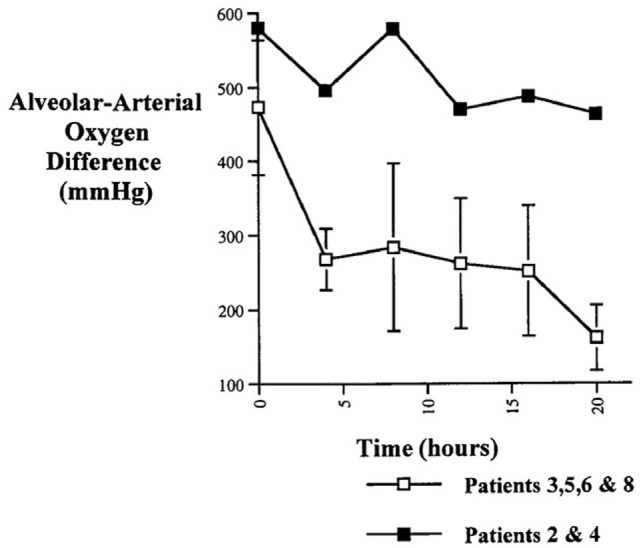
Time course of mean AaPO2 after the onset of reperfusion pulmonary edema. Comparison of mean AaPO2 in four patients with intact alveolar epithelial fluid clearance (open squares) to the patients with no net alveolar epithelial fluid clearance (solid squares). The data for Patients 3, 5, 6, and 8 are expressed as mean 6 SD. The data for Patients 2 and 4 are expressed as the average of the AaPO2 at each time point (45). Reprinted with permission of the American Thoracic Society. Copyright © 2017 American Thoracic Society.